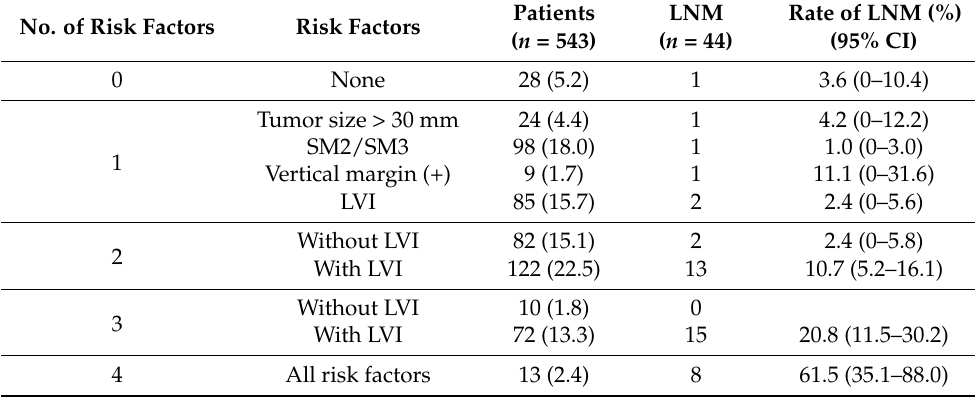
Table 4. Lymph node metastasis rate according to risk factors.